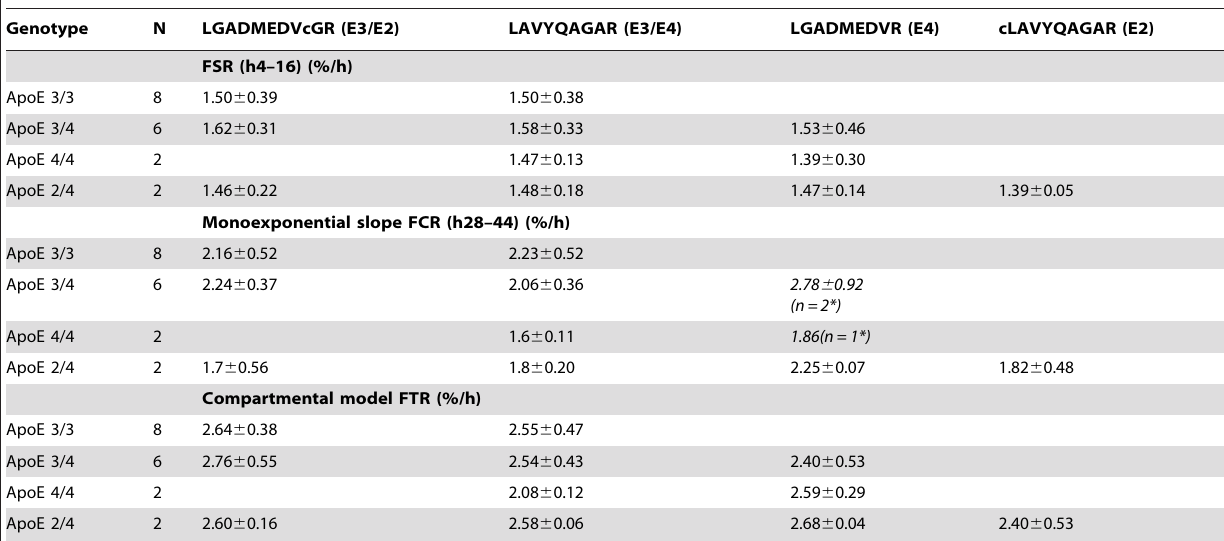
Table 2. CNS-ApoE Kinetic Parameters.